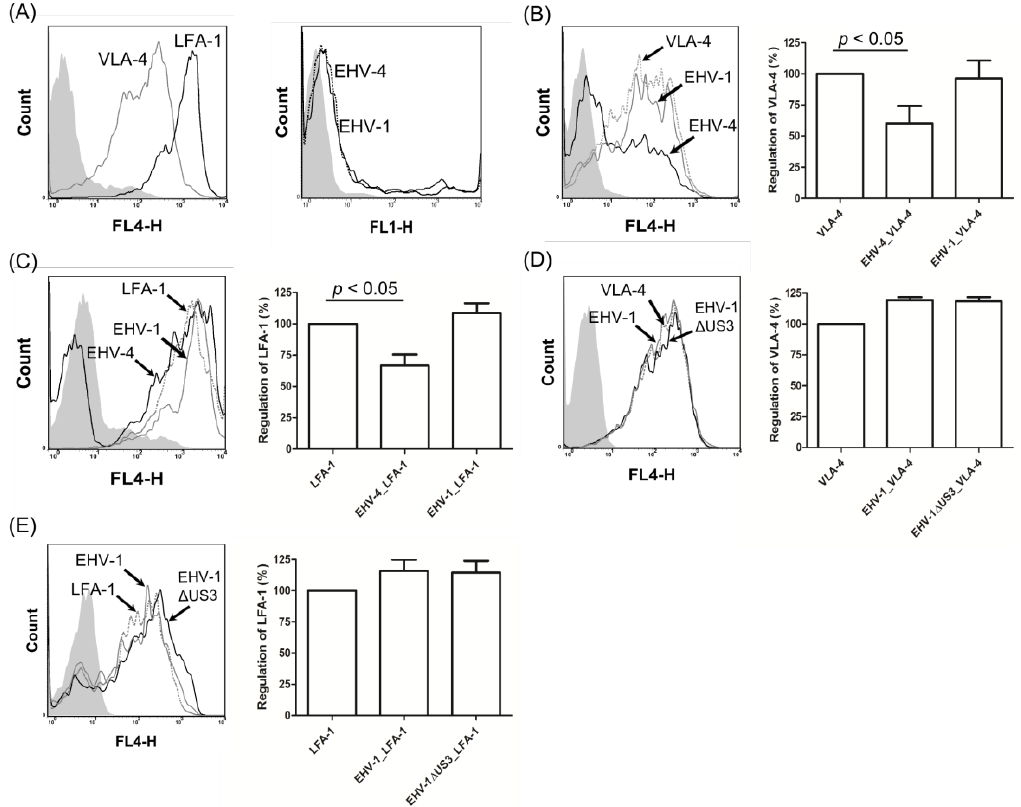
Figure 5. EHV-4 downregulates cell surface adhesion molecules on peripheral blood mononuclear cells (PBMC). ( A ) surface expression of very late antigen-4 (VLA-4) and lymphocyte function-associated antigen-1 (LFA-1) on the surface of mock-infected PBMC and virus infection ( black line: EHV-1; dotted line: EHV-4) levels of PBMC were determined by flow cytometry. ( B and C ) Equine PBMC were either mock-infected or infected with EHV-4 or EHV-1 and subjected to flow cytometric analysis. Histograms and bars of VLA-4 ( B ) and LFA-1 ( C ) expression after detection with the relevant antibodies are shown. Viable cells (10,000) were analyzed for each sample. Grey filled: mock-infected cells; dotted line: mock-infected cells with the relevant antibody; black line: EHV-4-infected cells; grey line: EHV-1-infected cells. For the bars, the expression level of adhesion molecules (VLA-4 or LFA-1) was set to 100%. All data represent the mean ± SD of three independent experiments. A significant downregulation (one-way ANOVA; p < 0.05) of VLA-4 and LFA-1 for EHV-4-infected cells was seen when compared to mock- or EHV-1-infected cells. (D and E) PBMC were either mock-infected or infected with EHV-1ΔUS3 and subjected to flow cytometric analysis. Histograms and bars of VLA-4 ( D ) and LFA-1 ( E ) expression are shown. Grey filled: mock-infected cells; dotted line: mock-infected cells with the relevant antibody; grey line: EHV-1-infected cells; black line: EHV-1ΔUS3-infected cells. Data are from one representative experiment out of three. FL1 and FL4: fluorescence detector. 3.5. Accumulation of Enveloped Virions within Perinuclear Vesicles in the Absence of pUS3 ED cells were infected with parental, US3_1 -deleted, and US3_4 -recombinant viruses for 14 h and imaged by transmission electron microscopy. In cells infected with parental EHV-1 or recombinant viruses, numerous extracellular virions released into the extracellular space were readily identifiable (Figure 6). Non-enveloped nucleocapsids and primarily enveloped virions were also seen in the perinuclear space. Other stages of virion maturation, including naked nucleocapsids in the cytoplasm and enveloped virions within cytoplasmic vesicles, were also observed. In contrast, infection with US3_1 -deleted viruses resulted in the presence of a large number of enveloped virions that accumulated in the perinuclear space within vesicles formed by the inner